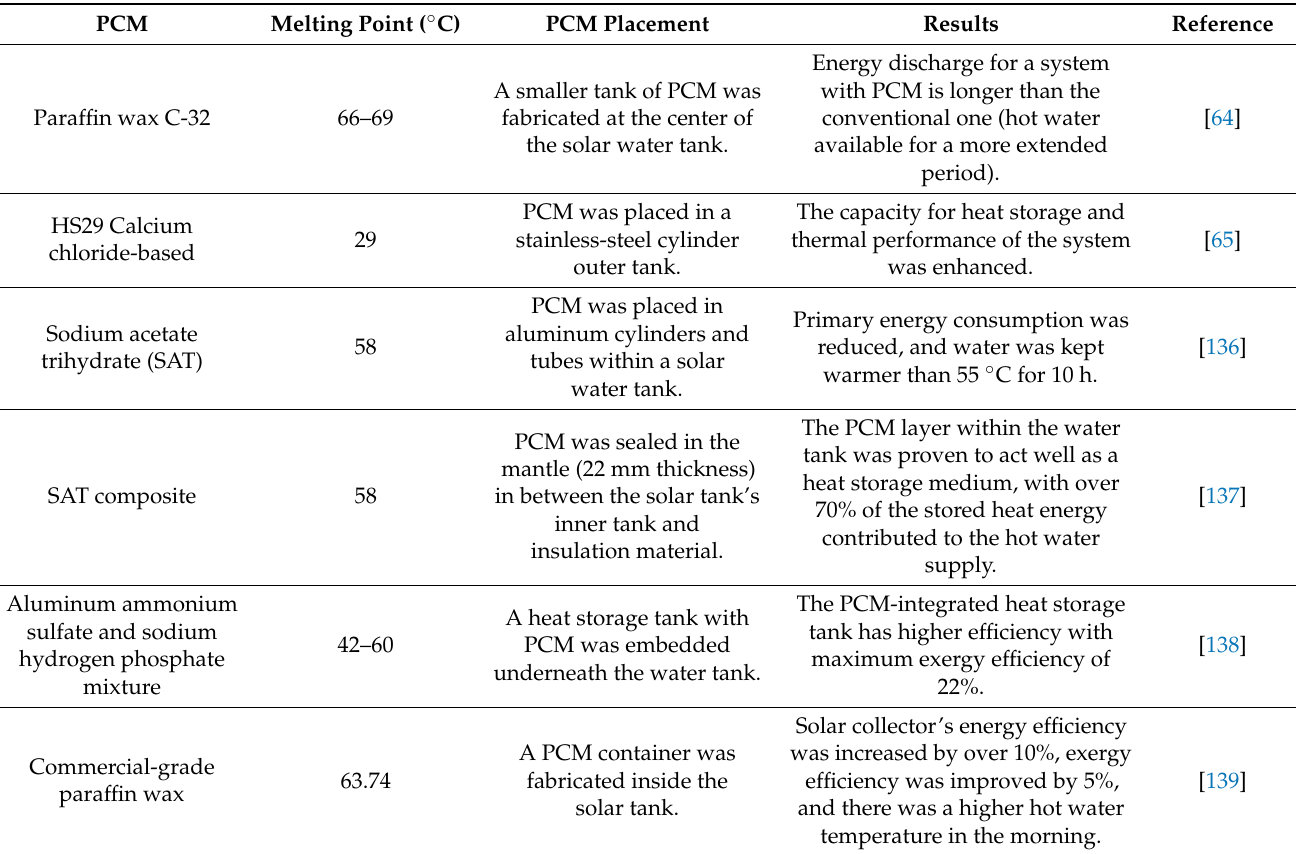
Table 7. A few studies on the integration of TES systems on solar water